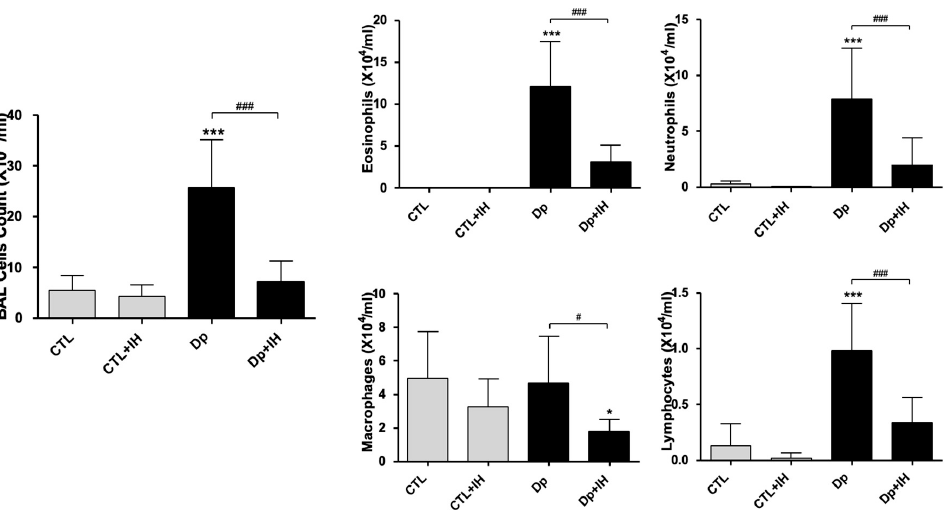
Figure 2. The number of inflammatory cells in the BALF. The number of eosinophils, neutrophils, macrophages, and lymphocytes. Data shown are the mean ± standard deviation ( n = 7). * p < 0.05 vs. CTL, *** p < 0.001 vs. CTL, ### p < 0.001, # p < 0.05.